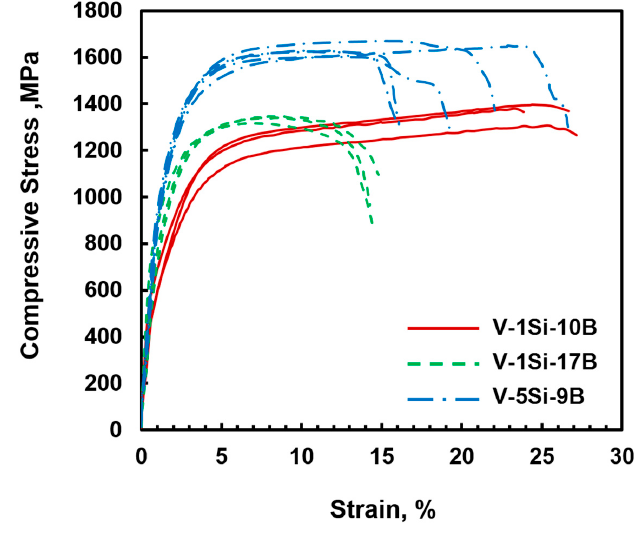
Figure 6. Compressive engineering stress vs. strain curves at room temperature of alloys V ‐ 1Si ‐ 10B, V ‐ 1Si ‐ 17B and V ‐ 5Si ‐ 9B.